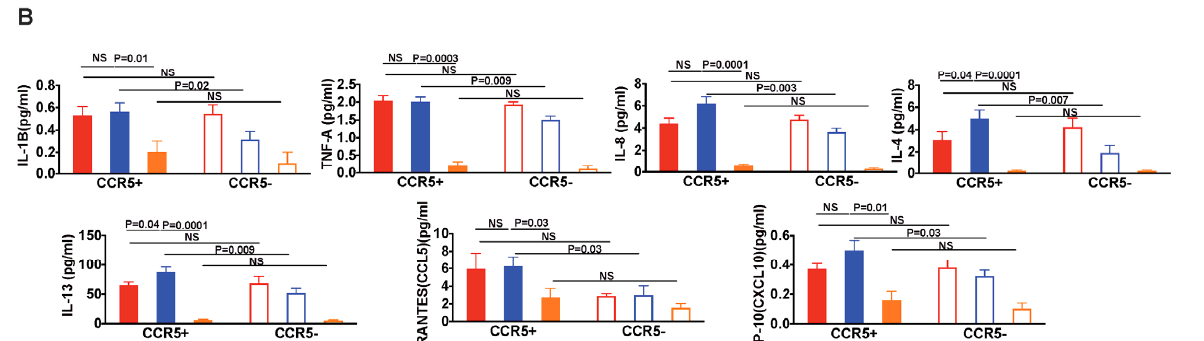
Figure 3. Functional analysis of HCV specific CCR5+ and CCR5 negative CD4+ T cells in HIV/HCV coinfection and HCV monoinfection. ( A ) Flow cytometry figures of a patient and bar graphs with HCV monoinfection, HIV/HCV coinfection and healthy controls demonstrating the differences in the functional response of CD4+CCR5+ after in-vitro stimulation with HCV peptides and media (served as negative control) in terms of IL-2, IFN-gamma and TGF- β production. ( B ) Bar graphs demonstrating the differences in the secretion of pro-Inflammatory (IL-1 β , TNF-A, IL-8) and pro-fibrotic (IL-4 and IL-13) cytokines and Chemokines (RANTES and IP-10) by CCR5+ T cells in HIV/HCV coinfection, HCV monoinfection and healthy controls. Data are expressed as (mean ± SEM) and the Wilcoxon matched-pair signed rank test was used to evaluate the functional differences between CCR5+ and CCR5 negative T cells within the same group and to analyze the differences between the two different groups non-parametric Mann–Whitney test was used. p values less than 0.05 were considered significant.